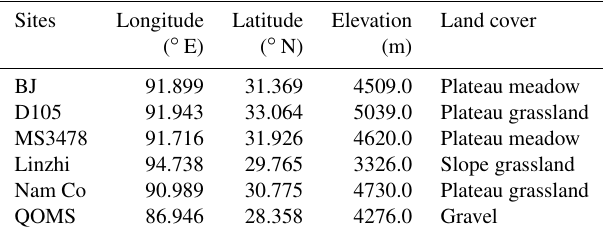
Table 1. Ground measurement sites Table 2. Summary of the input datasets used for calculating land surface heat